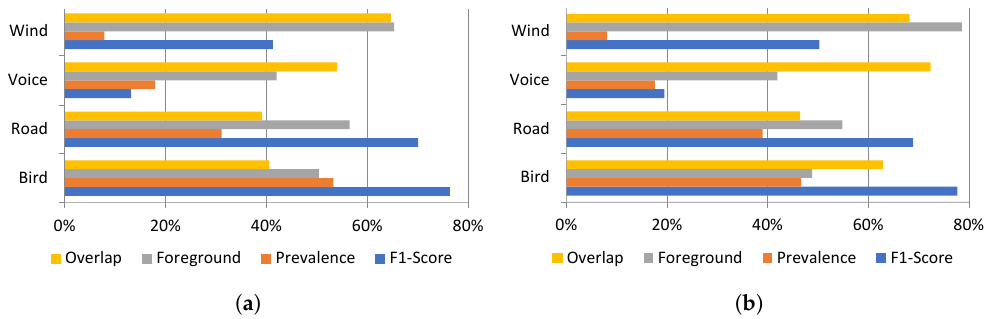
Figure 8. Comparative of the F1-Score of the 4 most prevalent classes related to their prevalence, overlapping and foreground to background ratio in ( a ) 2020 and ( b )